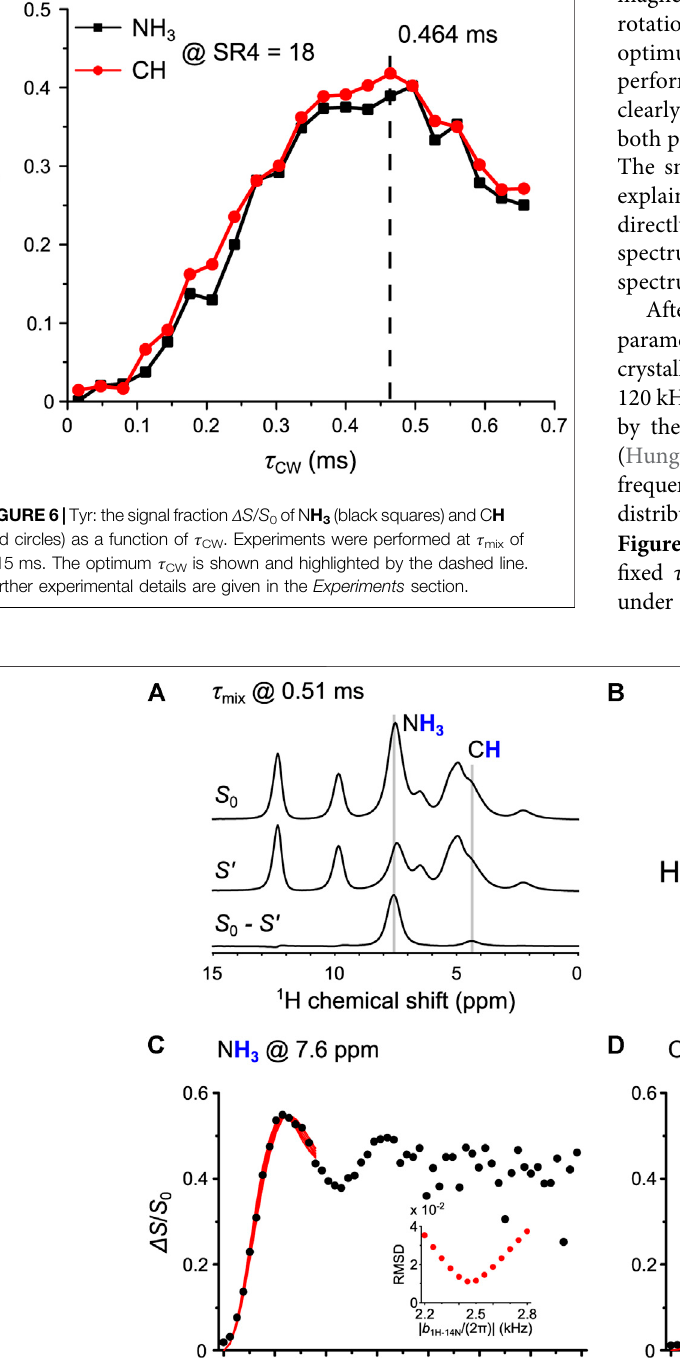
Frontiers in Molecular Biosciences |